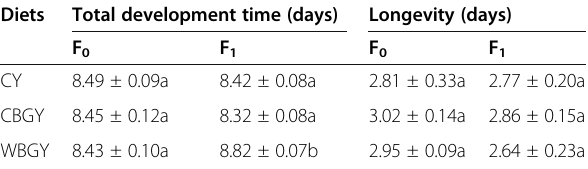
Table 4 Total development time and longevity of Trichogramma evanescens on different host diet